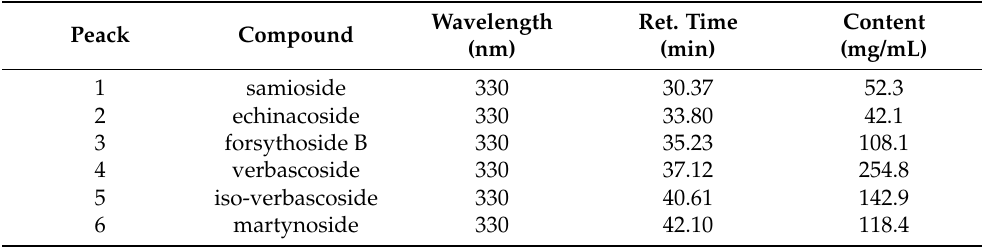
Figure 1. HPLC-DAD phenylethanoid glycosides fingerprint of V. thapsus leaf aqueous extract. Column: Ascentis Express C18, 15 cm × 4.6 mm, 2.7 µm d.p. The numbers indicating peaks refer to the identified and quantified compounds reported in Table 1. Table 1. Phenylethanoid glycosides identified and quantified in V. thapsus leaf aqueous by HPLC- DAD.